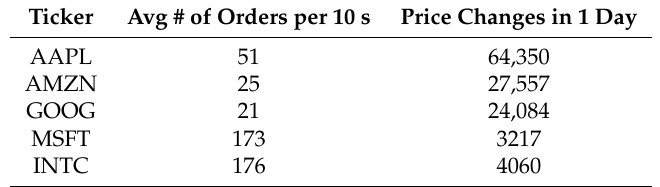
Table 1. Stock liquidity of AAPL, AMZN, GOOG, MSFT, and INTC for 21 June